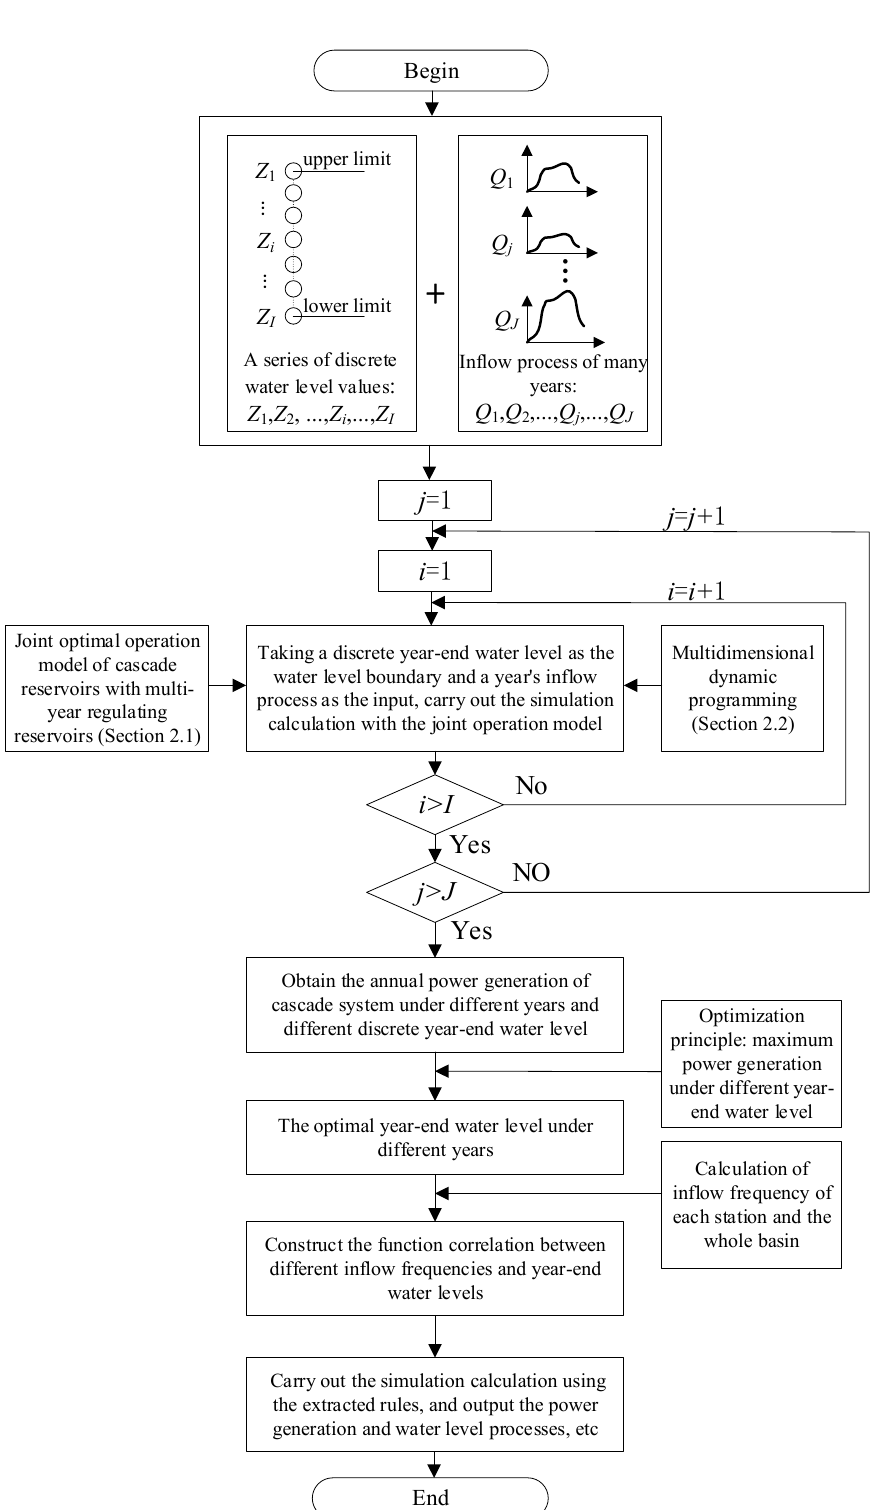
Figure 5. Year-end water level optimization of multi-year regulating reservoir.